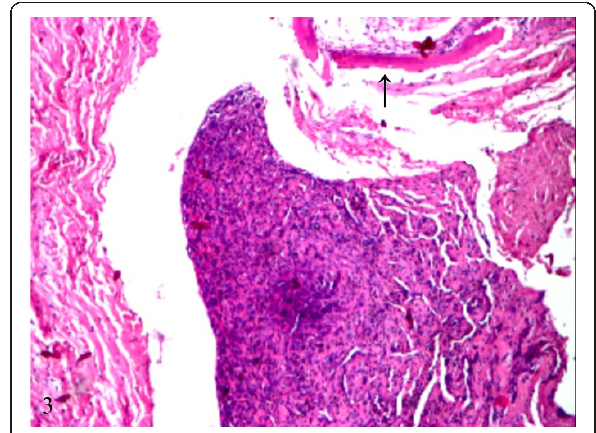
Figure 5 Detail of a tumoral area cells with clear intracytoplasmic vacuoles . Red blood cells are seen within the small vascular spaces. H&E stain, original magnification ×